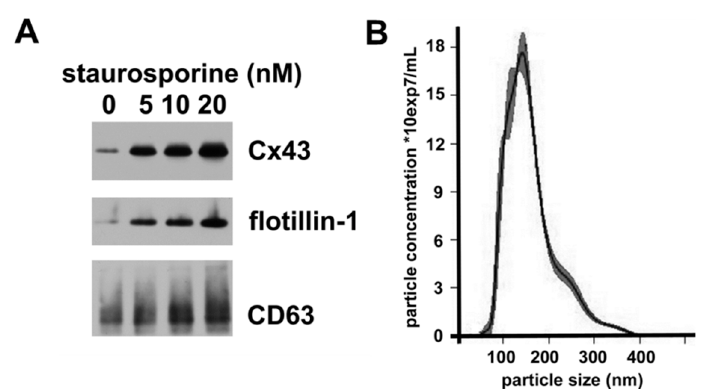
Figure 4. Treatment with staurosporine increases secretion of vesicles containing exosomal proteins and Cx43. ( A ) Cells were treated for 18 h with different concentrations of staurosporine (as indicated). The 100,000 × g pellets were isolated by centrifugation of the culture medium, they were resuspended, and, for each blot, identical volumes were immunoblotted to detect Cx43, flotillin-1 and CD63. ( B ) Graph shows the profile from the nanoparticle tracking analysis of the extracellular vesicles in the 100,000 × g pellet prepared from cells treated with 10 nM staurosporine. For this profile, the mode was 141.6 nm; mean ± SD was 161 ± 57 nm; 10% were <101 nm; 50% were <148 nm; and 90% were <241 nm.